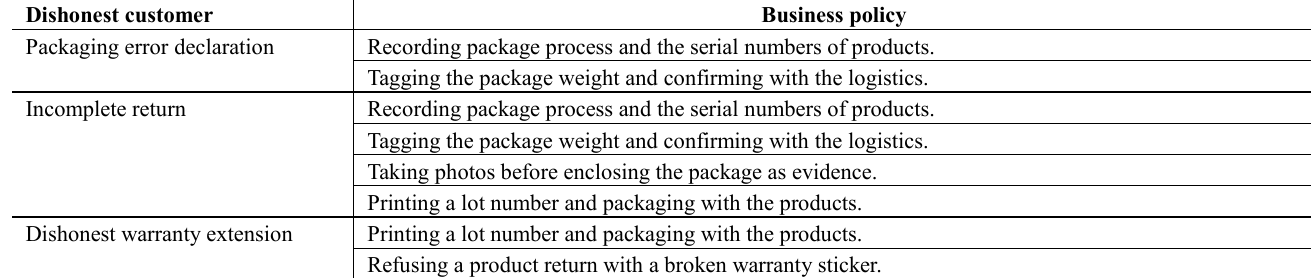
Table 3: Prevention business policies Dishonest